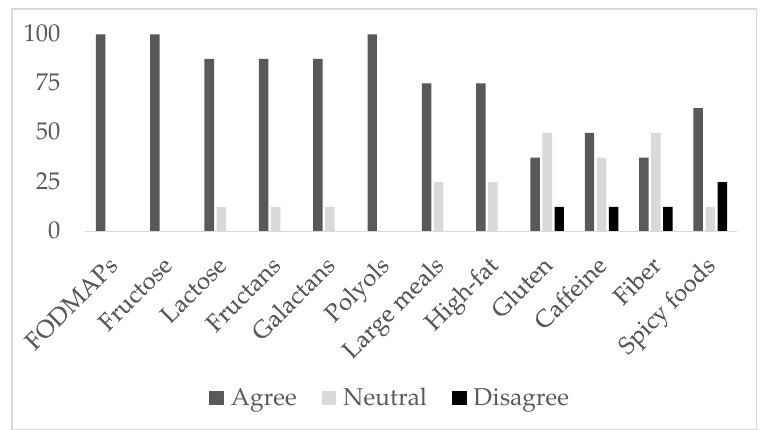
Figure 1. Intake questionnaire: provider perspectives prior to the study on whether they agree or disagree that select food groups are potential irritable bowel syndrome triggers. FODMAPs = fermentable oligo-di-monosaccharides and polyols.